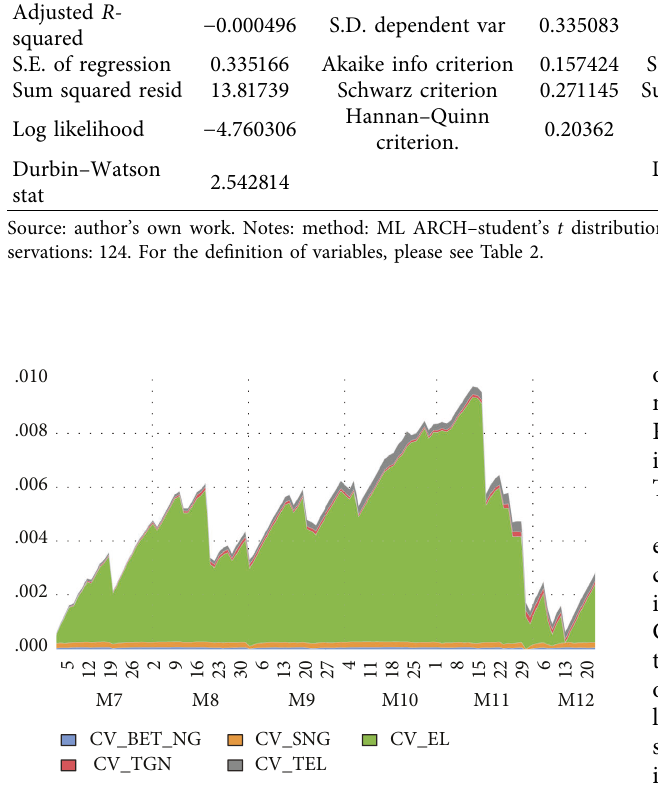
Figure 7: Conditional volatility (CV) plot of Romanian stock market index and energy companies. Source: author’s own